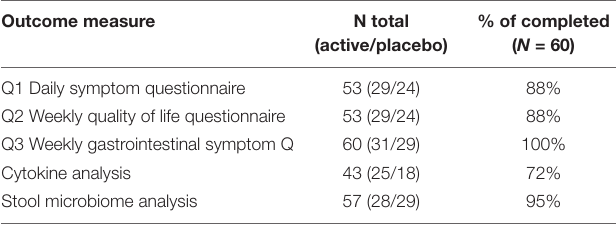
TABLE 3 | Participants and available